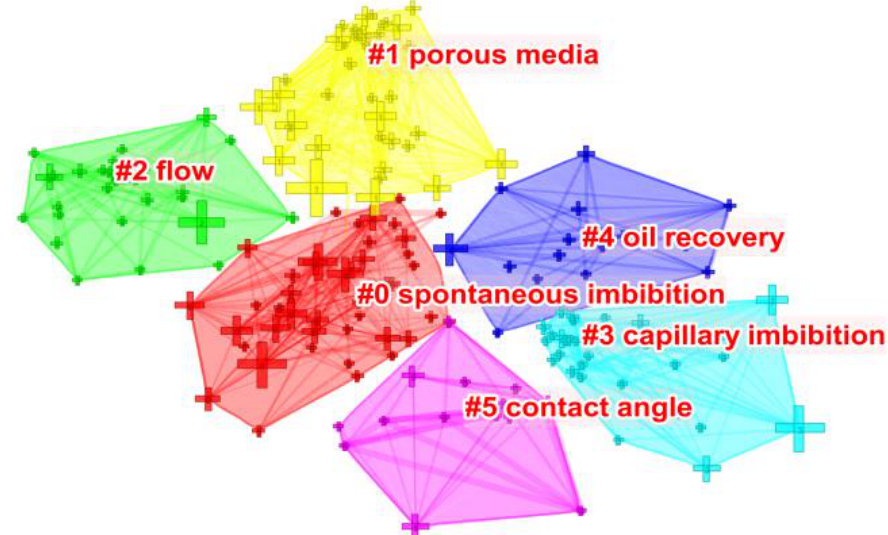
Figure 13. Main clusters in imbibition research. Table 5. Six main clusters in imbibition studies.